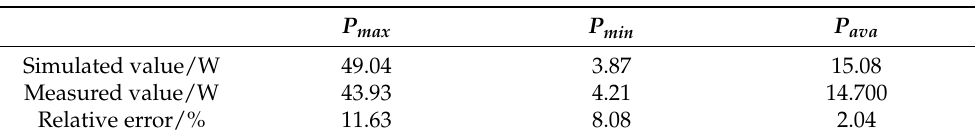
Table 3. Comparison of maximum, minimum, and average values between simulated and measured